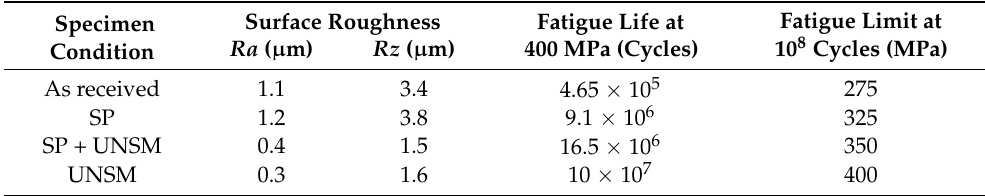
Table 2. Comparison of specimen conditions, surface roughness, average specimen fatigue lives at 400 MPa, and fatigue limits at 10 8 cycles for AISI 4340 steel specimens in as-received condition and after SP, UNSM, and SP + UNSM treatments. Measurements for fatigue lives and fatigue limits were based on rotary bending fatigue test results [28].